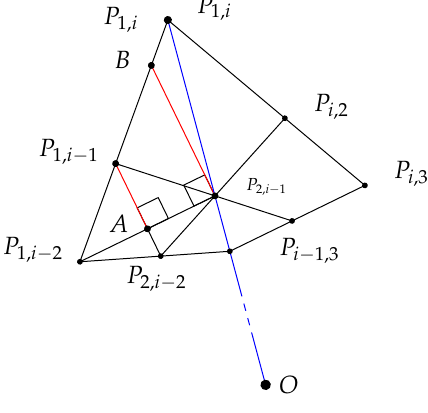
Figure 11. The apex of the intersection of circumscribed edges and their